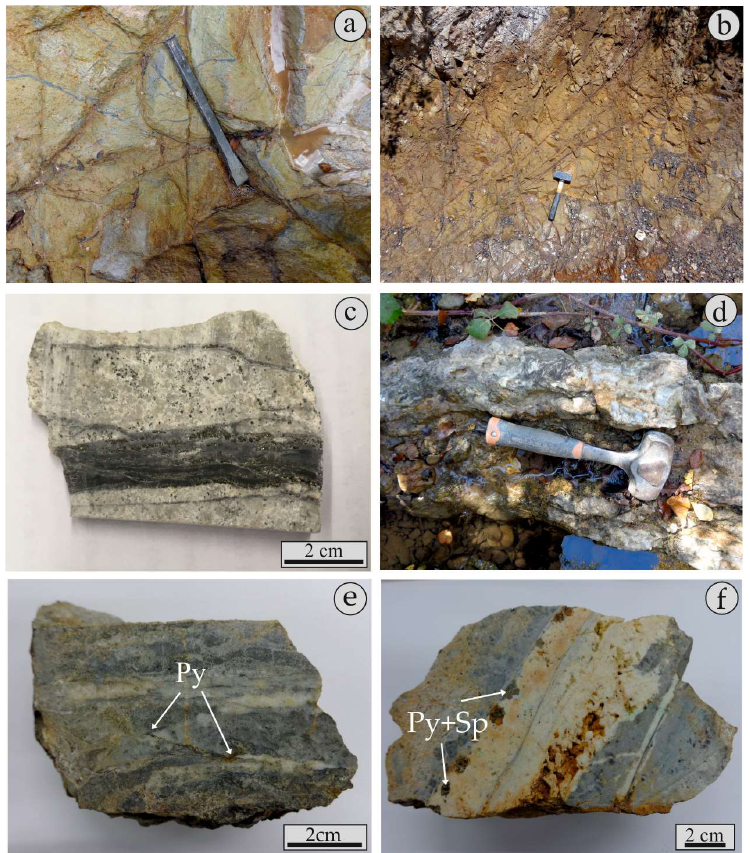
Figure 3. Field and hand-specimen photographs of pyrite-bearing ores from the Konos Hill porphyry-epithermal prospect: ( a ) Oxidized D-type veins crosscutting sericitic-altered granodiorite porphyry; ( b , c ) Surface outcrop of quartz stockwork veins crosscutting sericitic-altered granodiorite porphyry. Note in c that pyrite is mostly deposited along center lines of the quartz veins (sample KMSP64); ( d ) NNE-trending, epithermal-style, milky quartz-calcite vein (E-type) associated with quartz-sericite-calcite alteration of the host granodiorite porphyry; ( e ) Hand specimen with pyrite (Py) from the quartz-calcite vein shown in ( d ) (sample KMSP48); ( f ) Epithermal-style, quartz-calcite (E-type) vein with pyrite (Py) and sphalerite (Sp), (sample KMSP78). Pyrite is also widespread in epithermal-style (E-type) veins that crosscut/overprint the